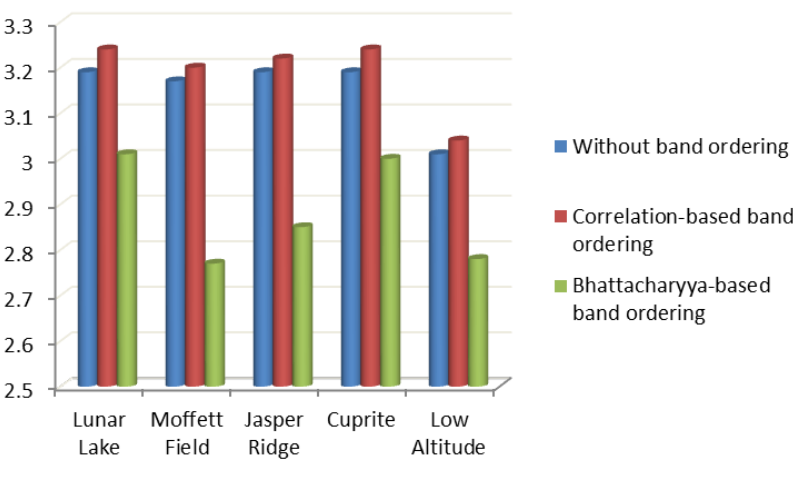
Figure 19. Average results in terms of